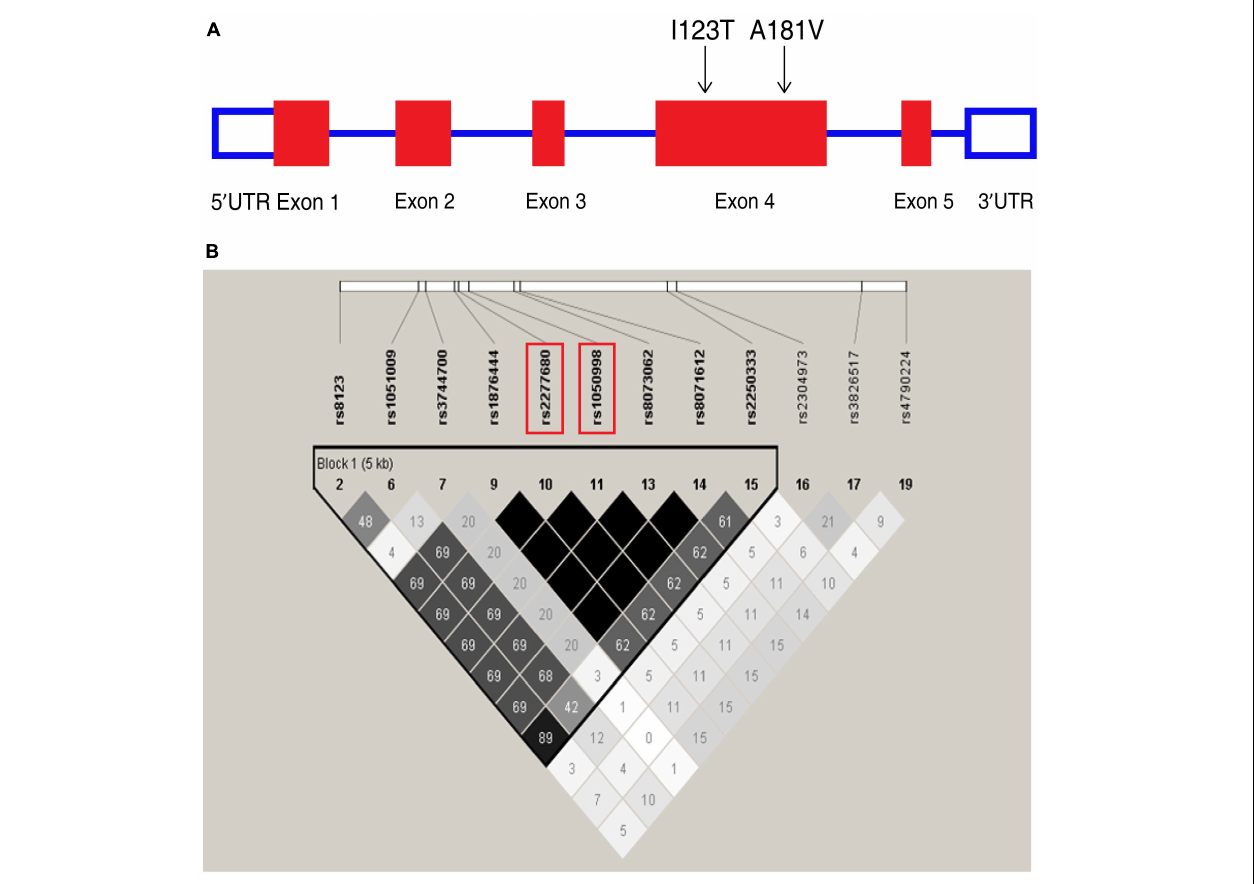
FIGURE 1 | Overview of tagging single nucleotide polymorphisms (tag SNPs) in the CXCL16 gene. (A) CXCL16 gene organization and the location of two missense mutations, I123T (rs1050998) and A181V (rs2277680), on chromosome 17. (B) Location of SNPs in the CXCL16 gene with a minor allele frequency ≥ 5%. A linkage disequilibrium (LD) plot of these SNPs is displayed by a color scheme. Black represents very high LD ( r 2 = 1.0), and white indicates the absence of correlation ( r 2 = 0) between two SNPs. The r 2 between I123T and A181V is